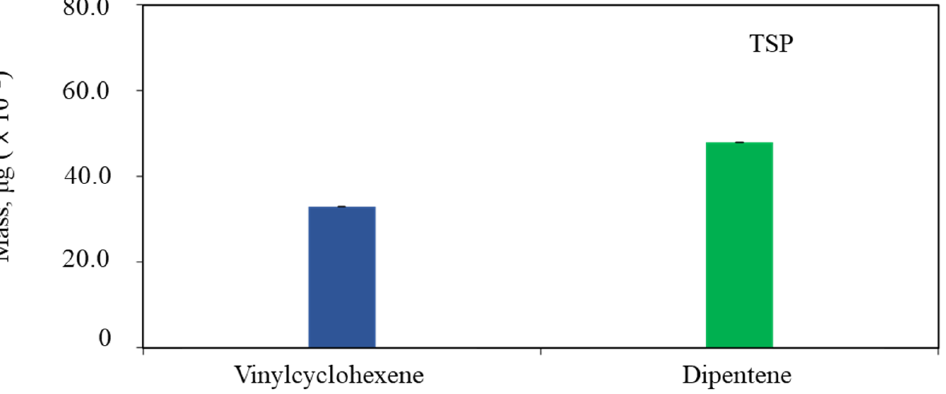
Figure 5. The average mass of vinylcyclohexene and dipentene was measured from the TSP samples. Error bars indicate 95% confidence intervals. Table 2. The average concentration, standard deviation, and variation for TP and TRWP in the air. Classification